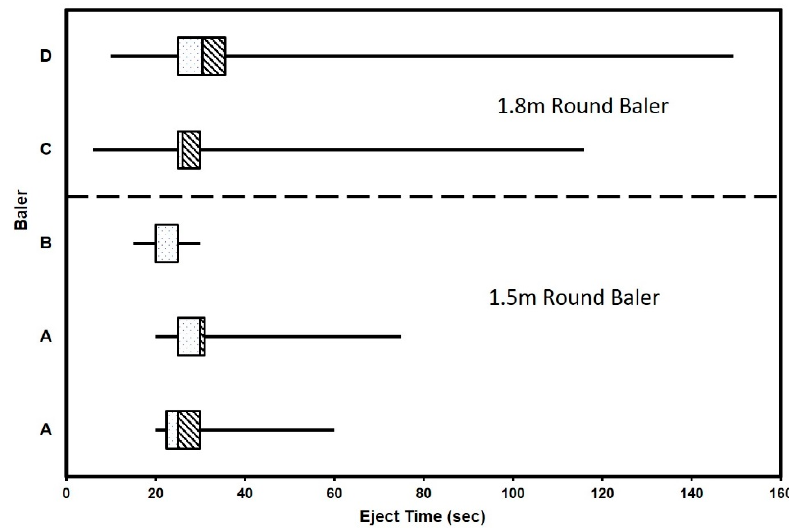
Figure 2. The box–whiskers graph of the wrap-eject time from round balers. Tails represent the highest and lowest extremes and the box ends are the 25th and 75th percentiles and the solid line in the box is the median. Table 3. Measured performance data for round and large-square balers (note, the capacity of a square baler does not include a bale wrap-eject time).